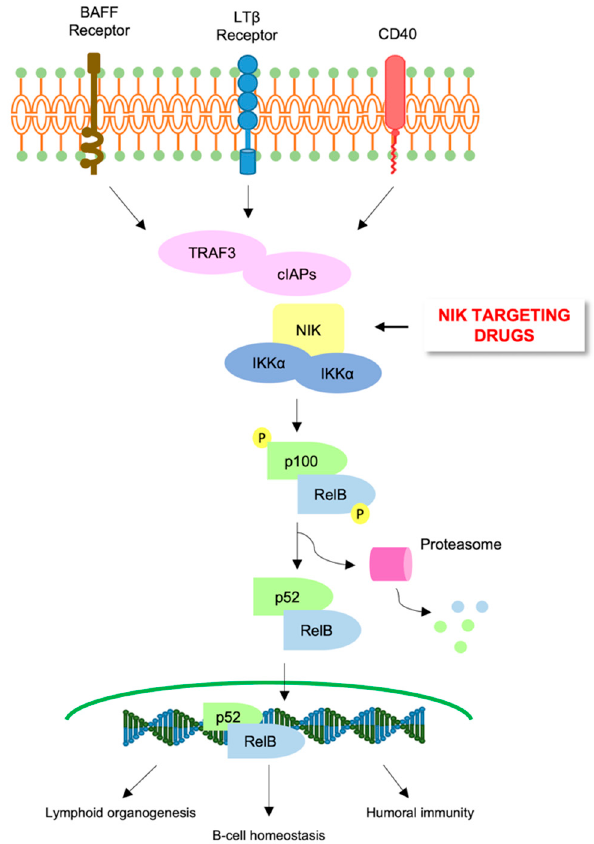
Figure 2. Targeting the NF- κ B non-canonical pathway in AML. Schematic representation of the NF- κ B non-canonical pathway showing that NIK stabilization suppresses tumor development and could be a potential strategy to treat AML.